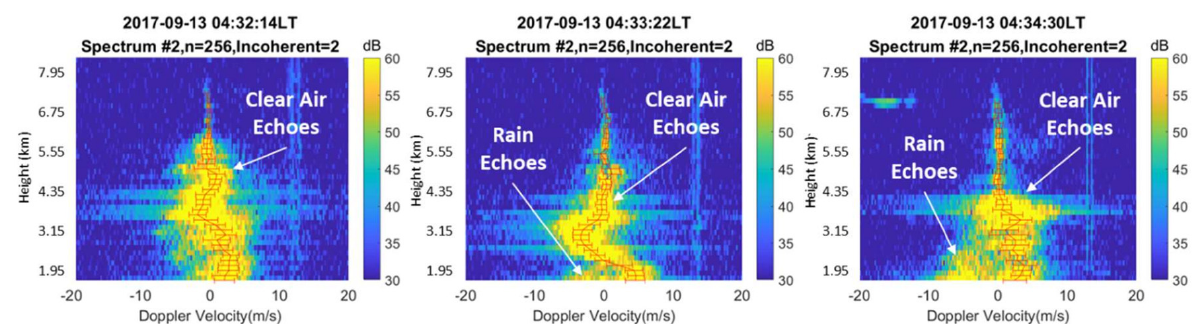
Figure 14. Examples of Doppler spectra observed by vertically pointed radar beam of the 52 MHz VHF radar in precipitation environment, in which spectral components of clear air and precipitation echoes are clearly